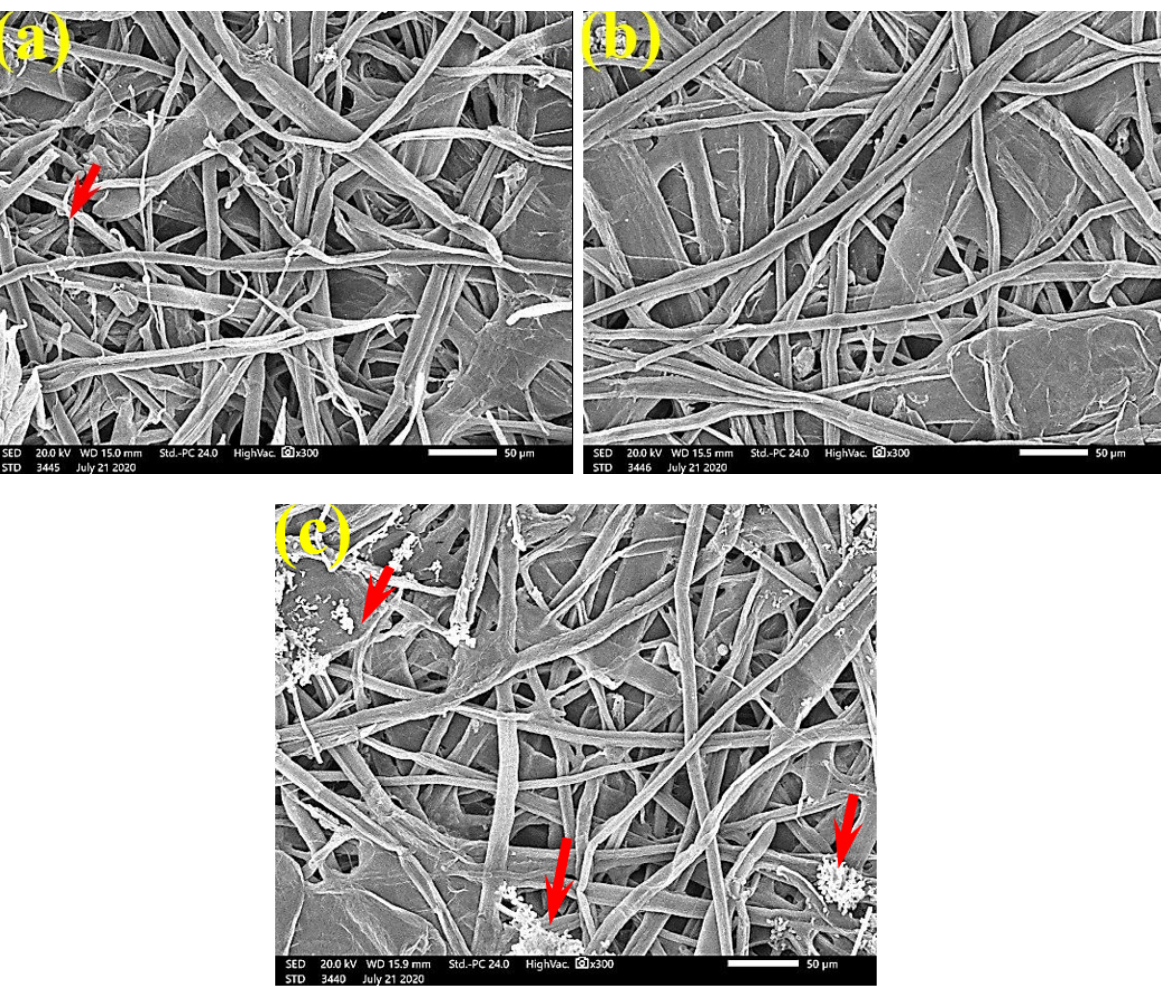
Figure 12. SEM images of the paper sheets manufactured from ( a ) B. speclabilis , ( b ) F. altissima , and ( c ) F. elastica treated with 1% MAHE and inoculated with S. solani . Arrows refer to low growth of fungal mycelia based on the concentration of the extract and the type of paper sheet